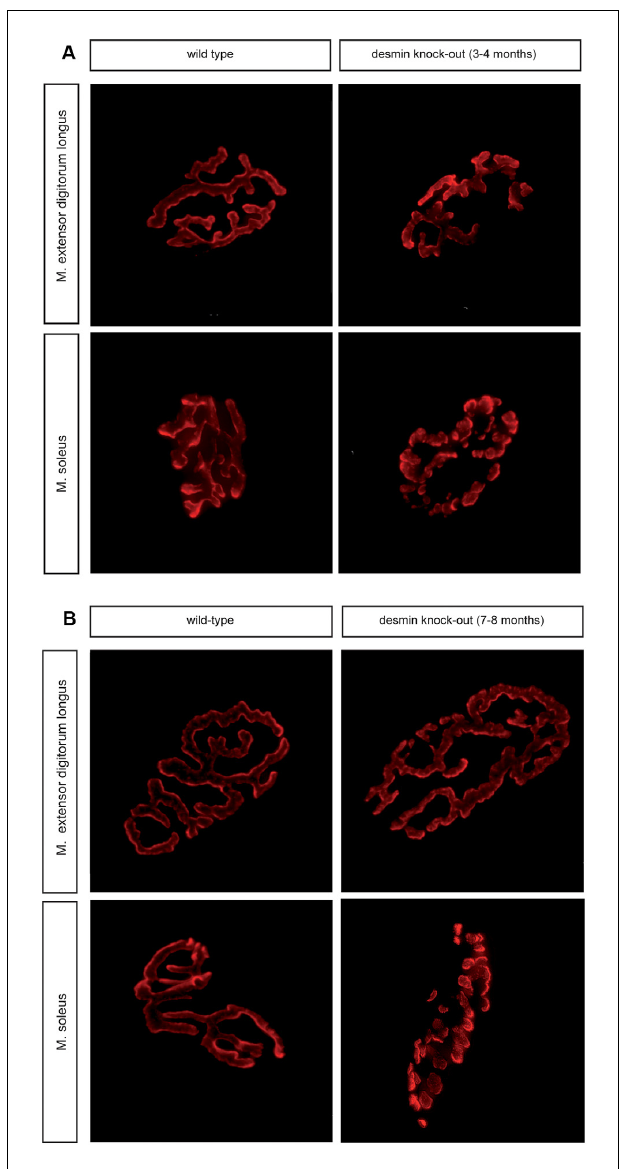
FIGURE 2 | Soleus muscle of desmin knock-out mice show a higher degree of fragmentation of their neuromuscular junctions (NMJs). (A) Representative images of BTX wild-type and desmin knock-out homozygous NMJs of oxidative soleus and glycolytic extensor digitorum longus muscles are shown. Note, NMJs of oxidative soleus muscle are fragmented in the absence of desmin. 3–4 months old mice were used. (B) Representative images of BTX wild-type and desmin knock-out homozygous NMJs of oxidative soleus and glycolytic extensor digitorum longus muscles are shown. Note, NMJs of oxidative soleus muscle are fragmented in the absence of desmin. 7–8 months old mice were